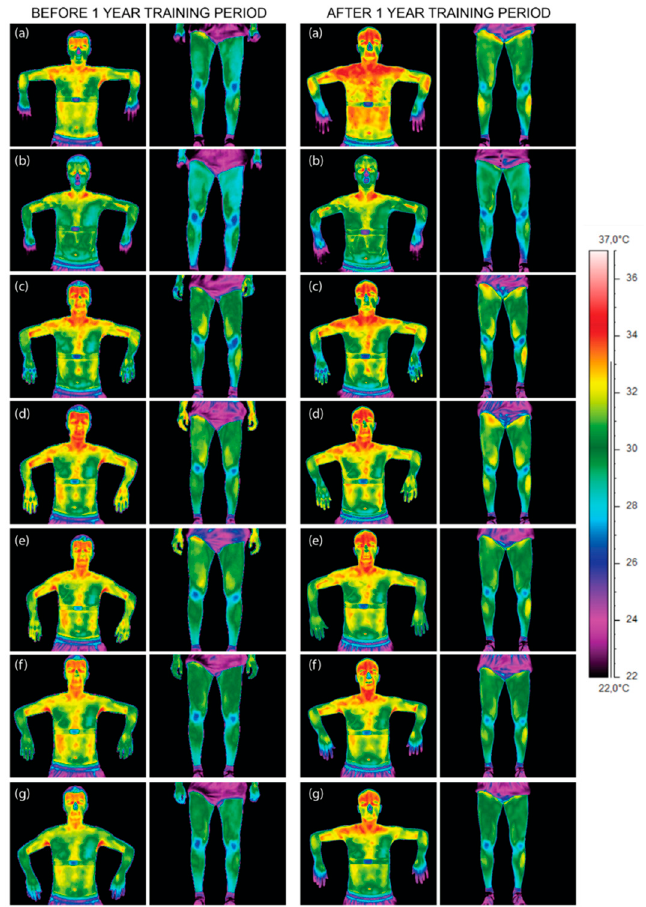
Figure 2. Thermal images of cycling volunteer’s chosen body parts before and after 1 year of professional training performed before ( a ), immediately after ( b ) and after 10 ( c ), 20 ( d ), 30 ( e ), 40 ( f ), and 50 min ( g ) of training.